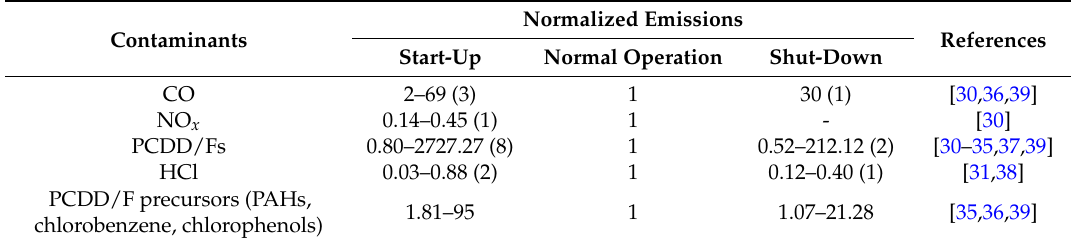
Table 5. Normalized emissions from waste incineration facilities under start-up, normal, and shut-down operating conditions (number of facilities investigated shown in